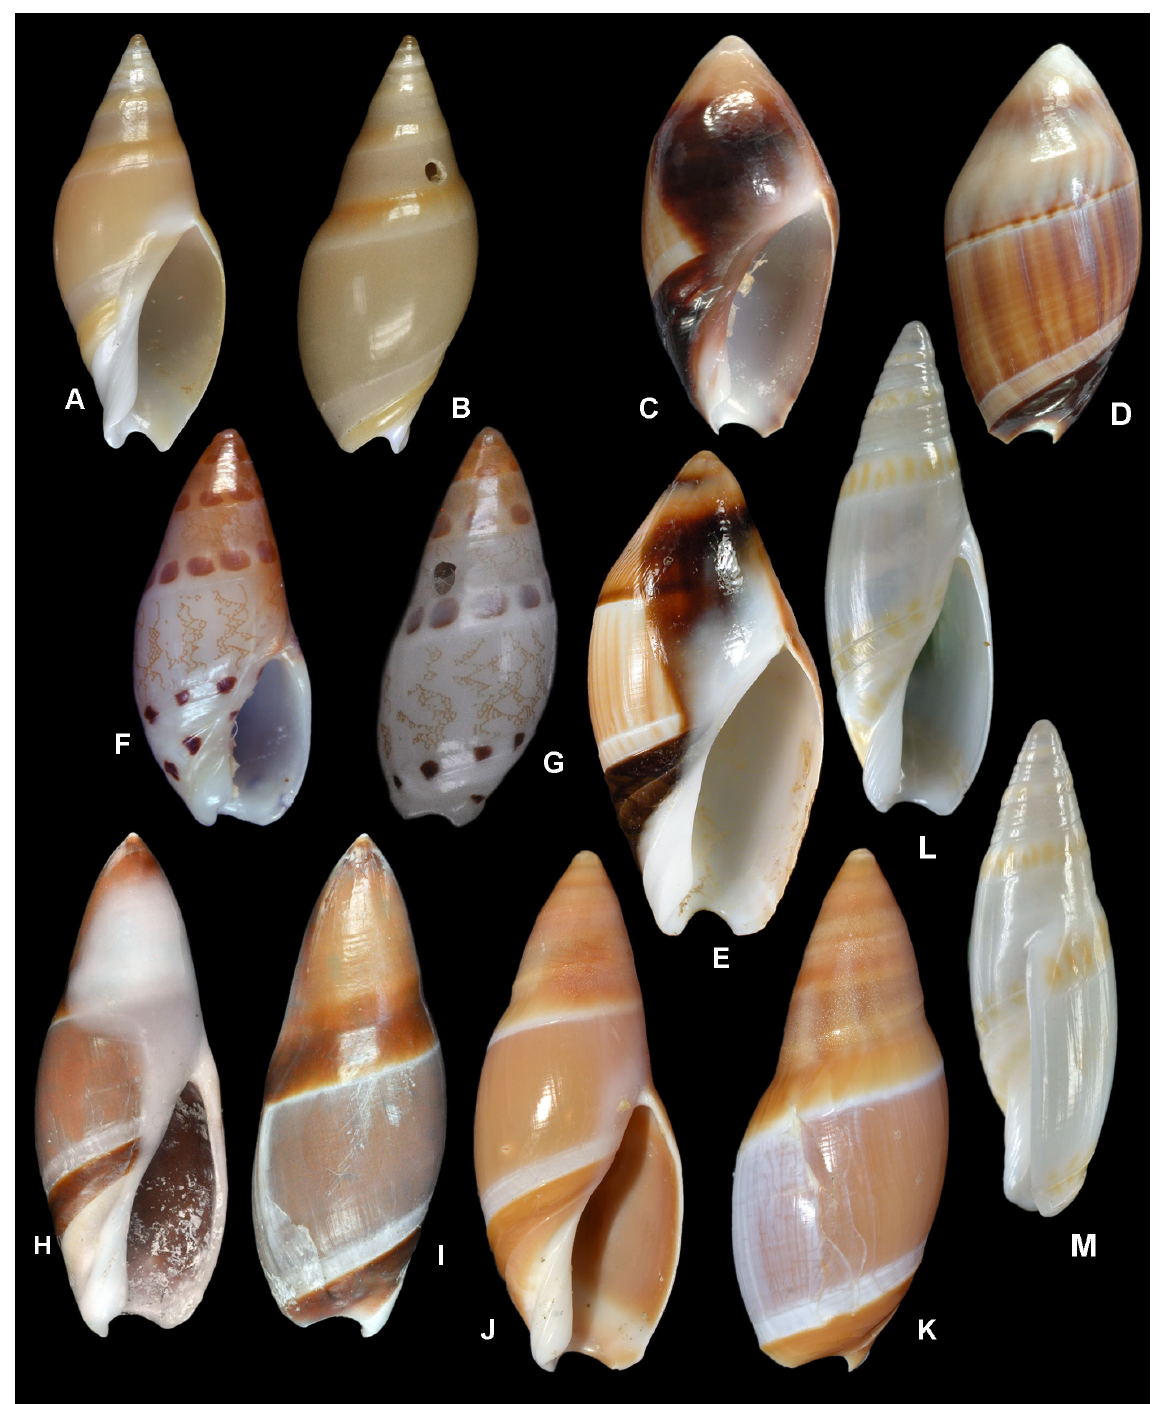
Fig. 19. Sequenced species of Amalda H. Adams & A. Adams, 1853. A–B . Amalda sp., MNHN